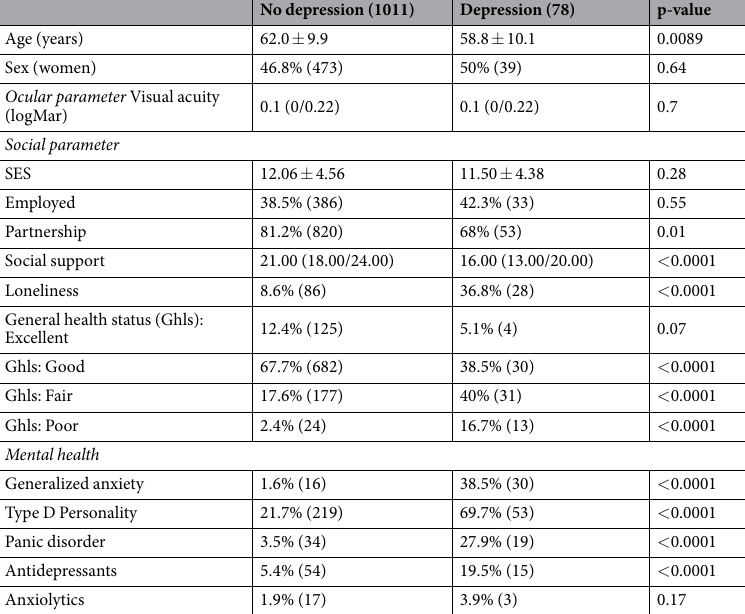
Table 9. Study characteristics of AMD participants with and without depression. Abbreviations: Glhs (general health status), SES (socioeconomic